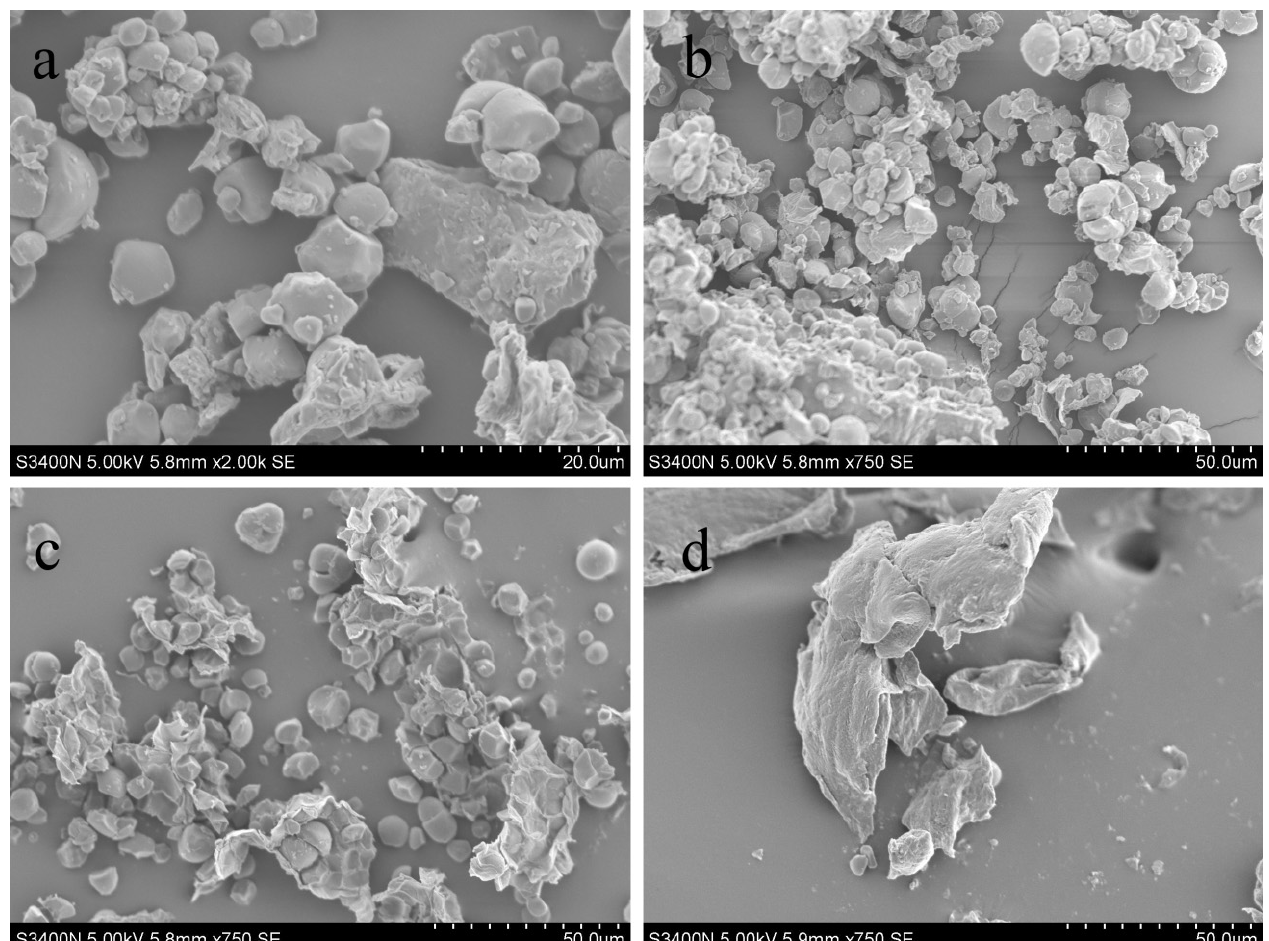
Figure 10. The field emission scanning electron microscope images: ( a ) unextracted A. dahurica powder, ( b ) 75% ethanol ultrasound, ( c ) methanol ultrasonic, and ( d ) the selected DES ultrasound.